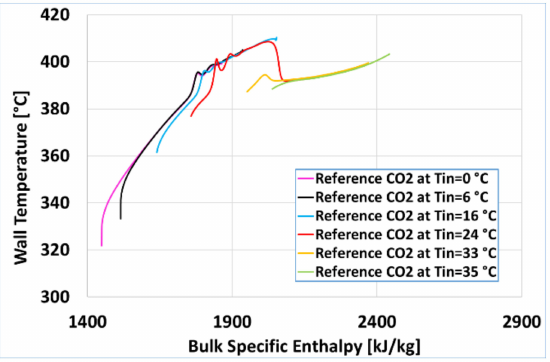
Figure 20. Trends of the wall temperature along the channel. RANS calculations with water at 25 MPa for the reference cases by Kline at q (cid:48)(cid:48) = 18 kW/m 2